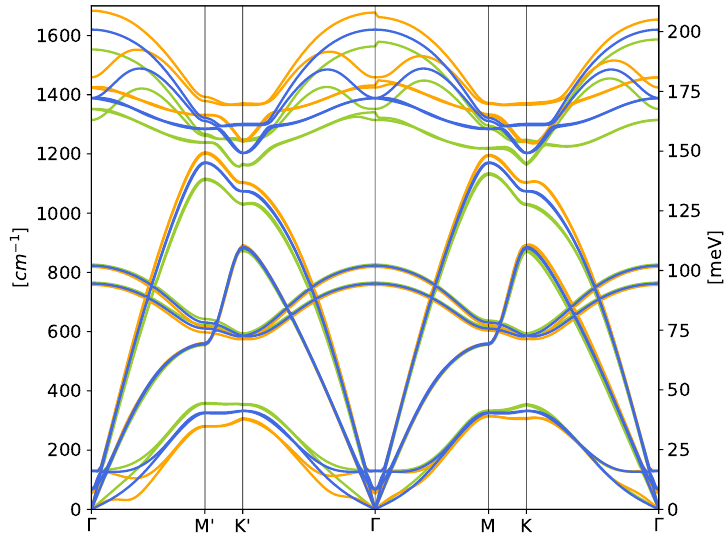
Figure 2: [ Color online ] Phonon band structure versus uniaxial strain. Blue lines are at equilibrium, green lines at 2.5% stretch and orange lines at 2.5%